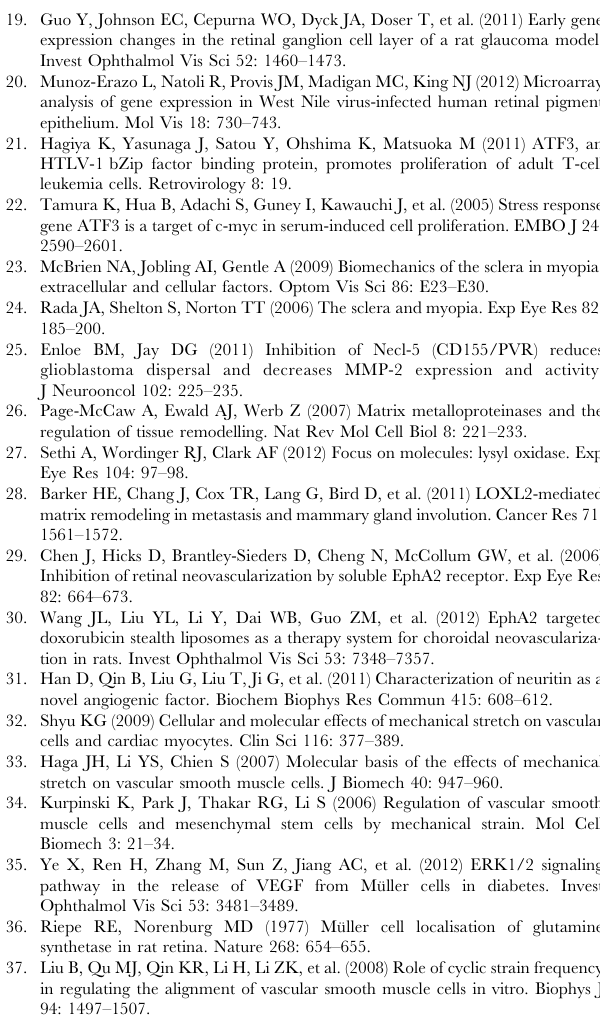
Table S1 Up- and downregulated genes in Mu¨ller cells after stretching for 1 h. Table S2 Up- and downregulated Genes in Mu¨ller cells after stretching for 24 h. Table S3 Significantly Upregulated Gene Categories after stretching for 1 h.